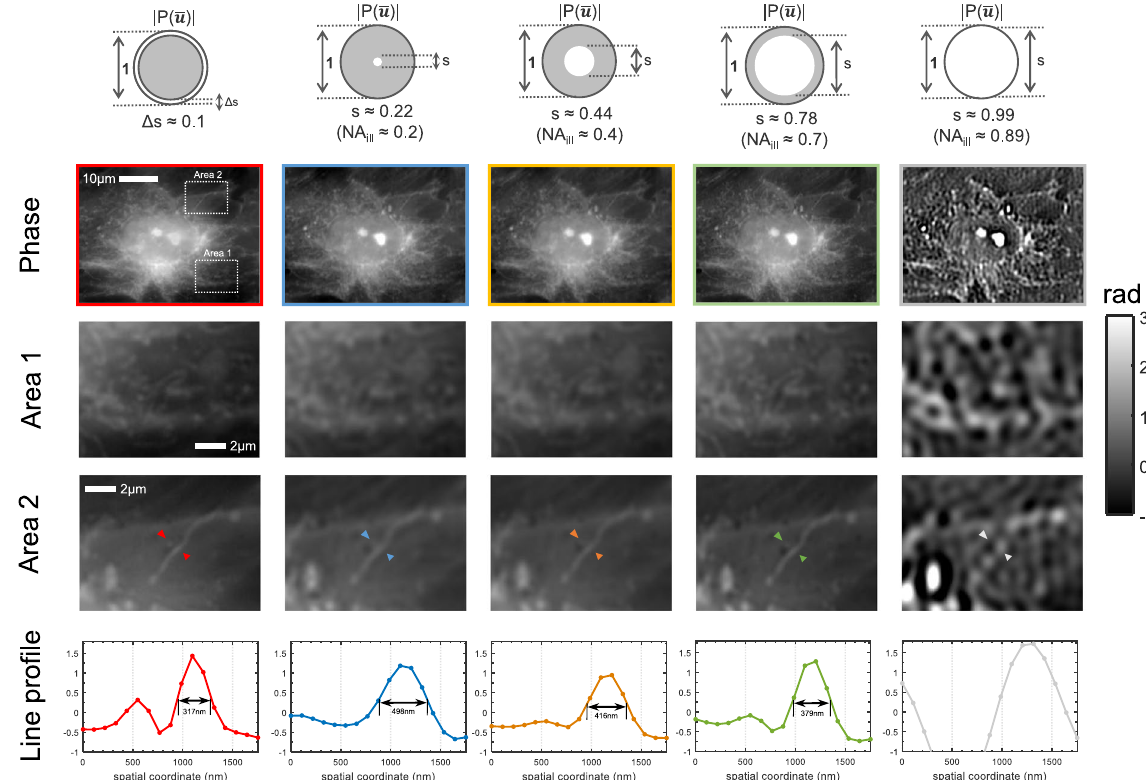
Figure 11. Comparison of imaging resolution between annular illumination TIE and circular illumination TIE for imaging of fixed human BMSC cells. Two areas (boxed regions) containing intracellular organelles near the nucleus are enlarged and shown in the second and third rows. The phase line profiles along the respective arrow are shown in the bottom